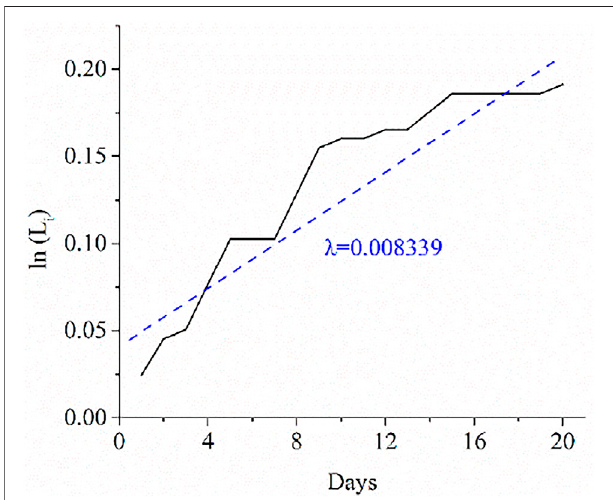
FIGURE 4 | Computation Lyapunov exponent.